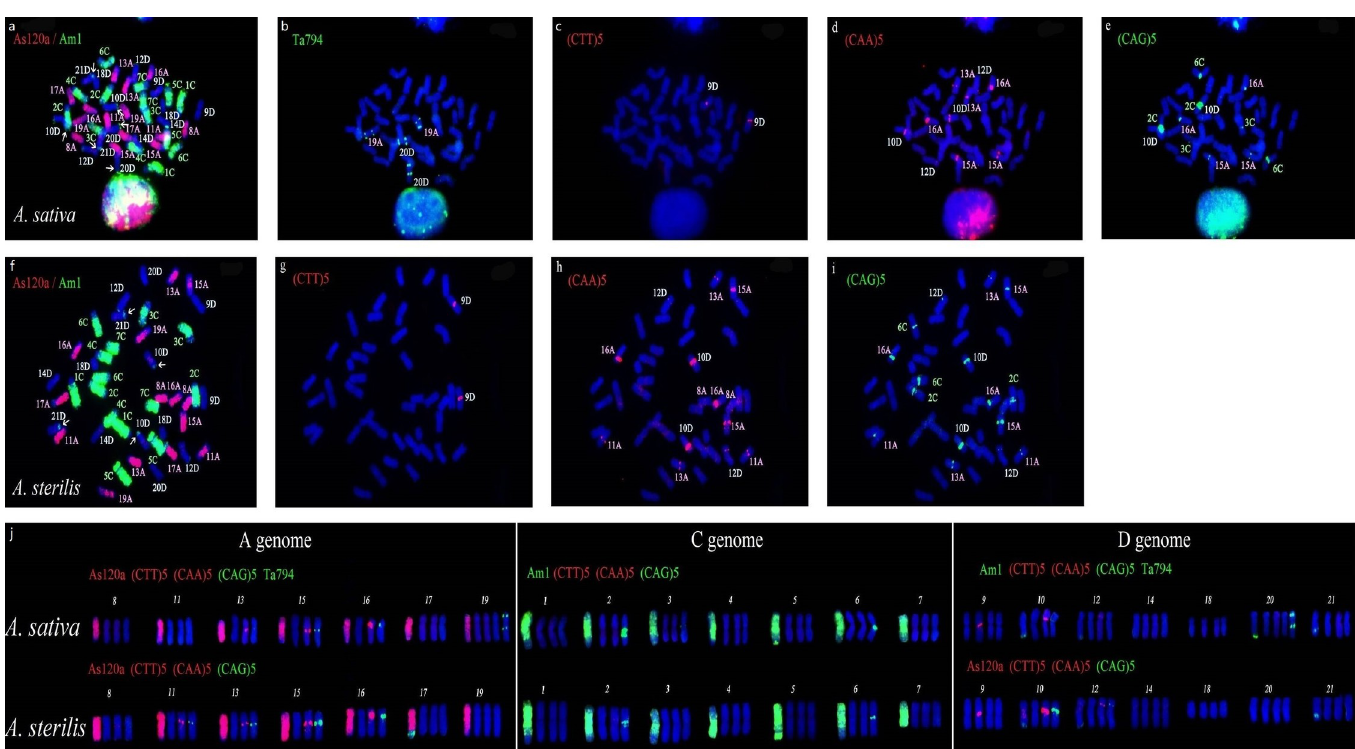
Fig 1. FISH performed on mitotic metaphase plates of hexaploid oats (a) A . sativa and (f) A . sterilis . The nomenclature system of Sanz et al. [40] was used to assign the chromosomes. (a) Simultaneous FISH of TAMRA-labeled As120a (red) and FAM-labeled Am1 (green). (b-e) The same cell as in panel ‘a’ after sequential FISH with FAM- labeled Ta794 (green), TAMRA-labeled (TTC) 5 (red), TAMRA-labeled (AAC) 5 , and FAM-labeled (CAG) 5 (green). (f) Simultaneous FISH of TAMRA-labeled As120a (red) and FAM-labeled Am1 (green). (g-i) The same cell as in panel ‘f’ after simultaneous FISH with TAMRA-labeled (TTC) 5 (red), TAMRA-labeled (AAC) 5 , and FAM- labeled (CAG) 5 (green). (j) Karyotypes showing a single chromosome of each homologous group chosen from the metaphases in panels ‘a’ and ‘f’. The white arrows indicate the C/D genome translocations.